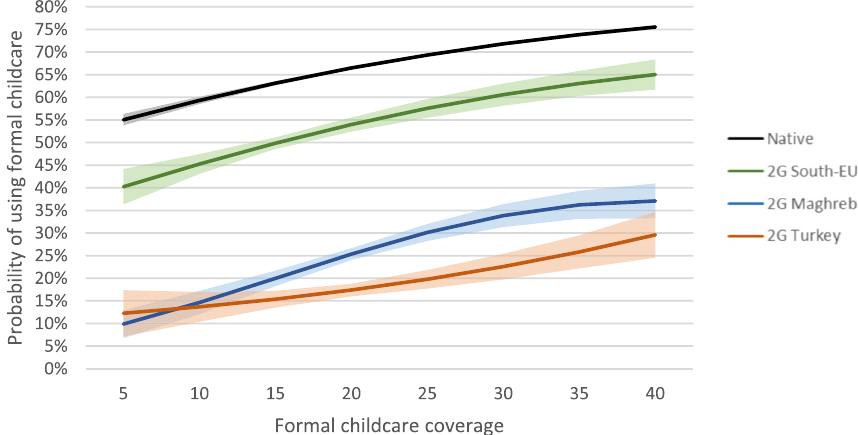
Fig. 5 Probability of using formal childcare at different levels of childcare coverage (with 95% conf. interval), by mothers’ origin group. Predicted probabilities based on Model 3 including municipality fixed effects, coverage (quadratic specification), origin, origin * municipality and origin * coverage (quadratic specification) (Source: Belgian Census 2011 linked to longitudinal register data, longitudinal tax return data on childcare expenses and municipality-level data on childcare coverage from K&G and ONE. Calculations by